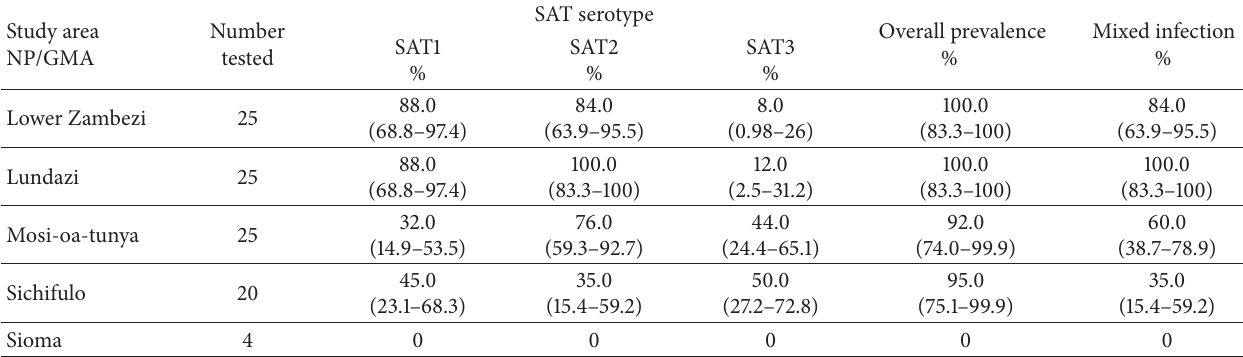
Table 1: Seroprevalence of FMDV by LPBE SAT.